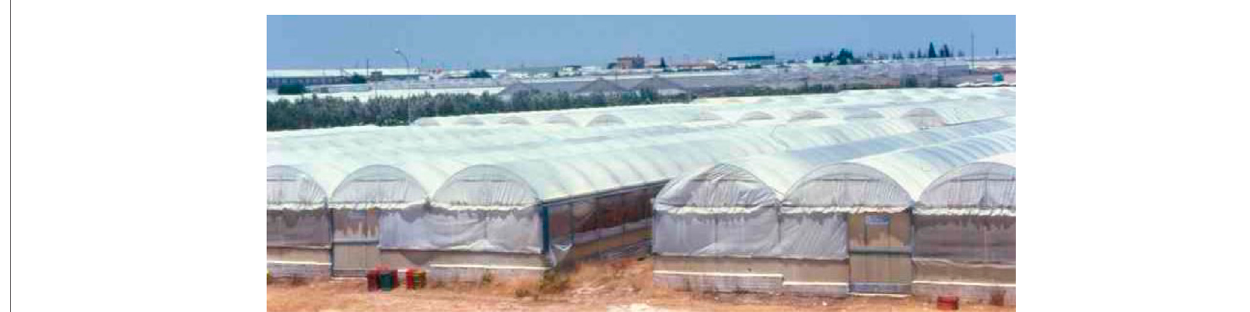
FIGURE 7 | Plastic-covered greenhouses.